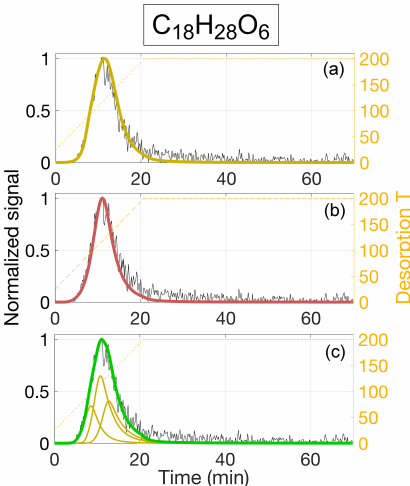
Figure 13. Three different ways of modeling the thermogram from C 18 H 28 O 6 , assuming direct evaporation of a single compound (a) , evaporation limited by thermal decomposition into C 18 H 28 O 6 (b) , or the direct evaporation of three isomers (c) . Data source, normal- ization, and color coding are the same as in Fig. 12, and the model parameters used are included in Table